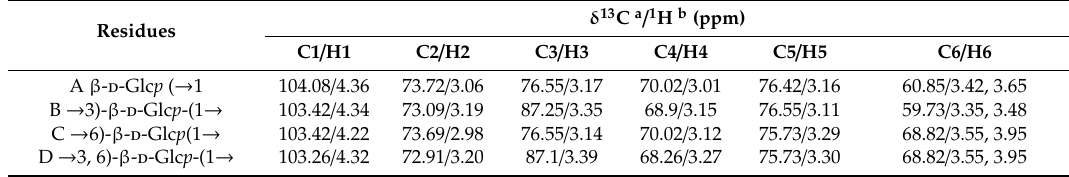
Table 2. The 13 C and 1 H NMR chemical shifts of the main residues from LeP-N2 in D 2 O / DMSO (1:6 v / v ). Residues